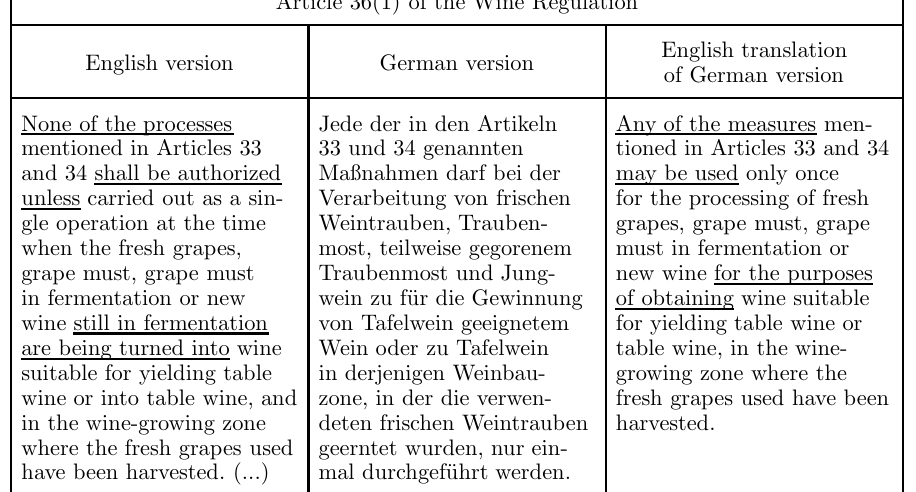
table wine, in the wine- growing zone where the fresh grapes used have been